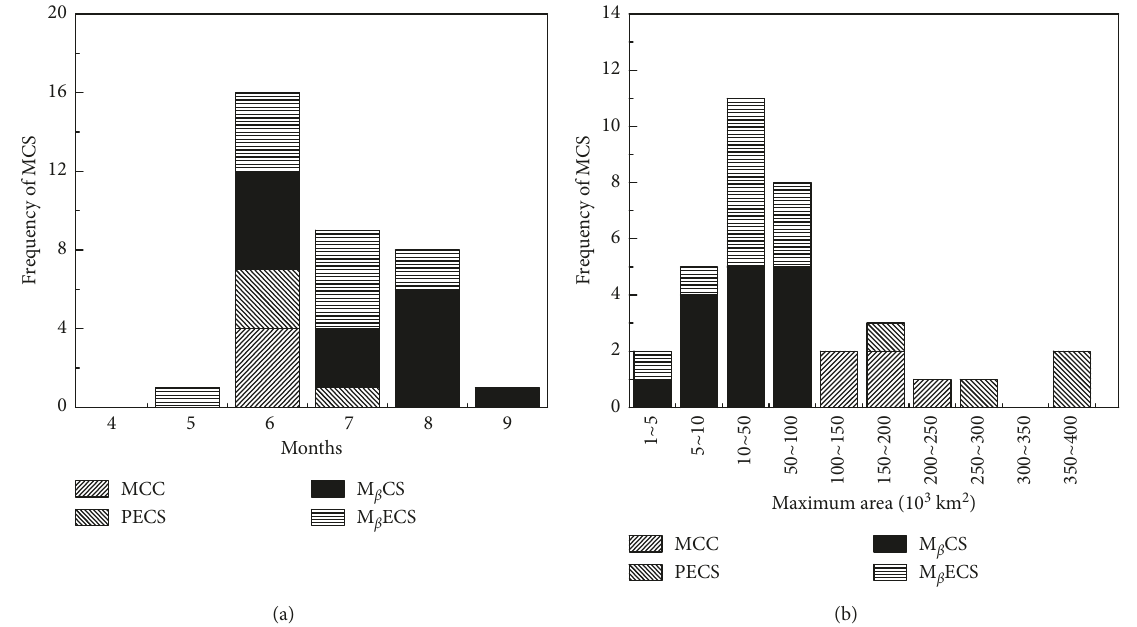
Figure 2: Shape distribution of MCSs by (a) month and (b) area.